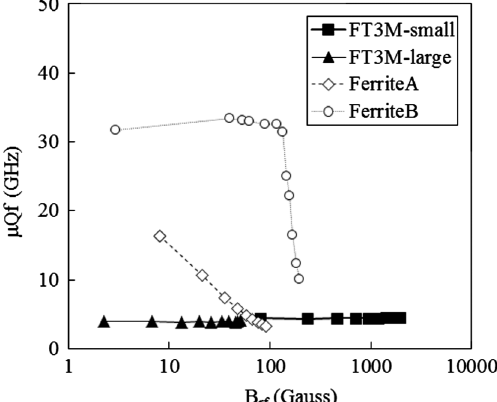
FIG. 2. Characteristics of MA cores. The present FT3M core (solid line) with 18 (cid:1) m layer thickness can be improved by the FT3L with 13 (cid:1) m thickness (bold line). The dashed and dotted lines mean the products of the FT3M with 13 (cid:1) m thickness and the FT3L with 18 (cid:1) m thickness, respectively. Both dashed and dotted lines show about 20% improvement compared to the present FT3M.